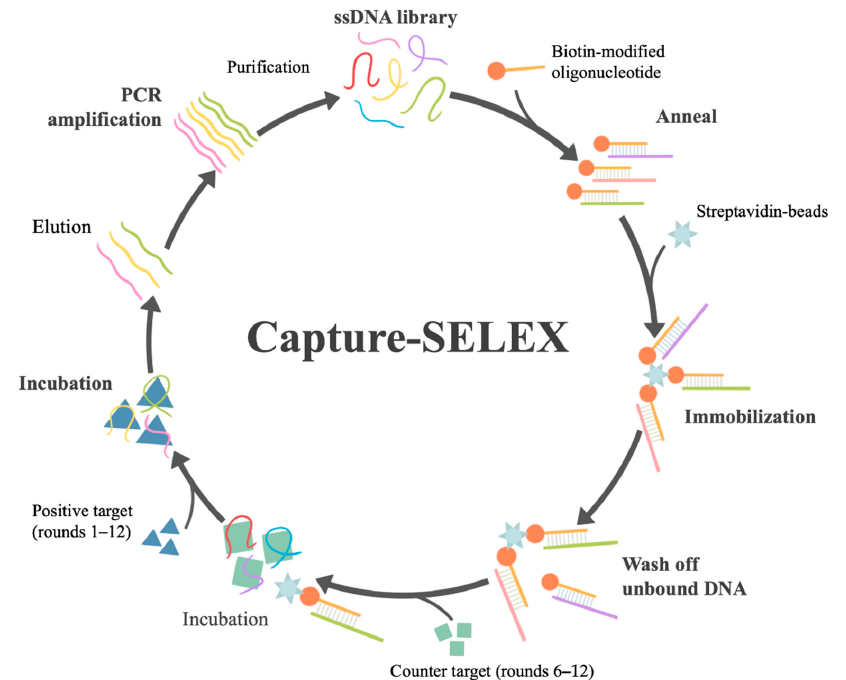
Figure 1. Key steps of Capture-SELEX. Each round of Capture-SELEX in this study mainly